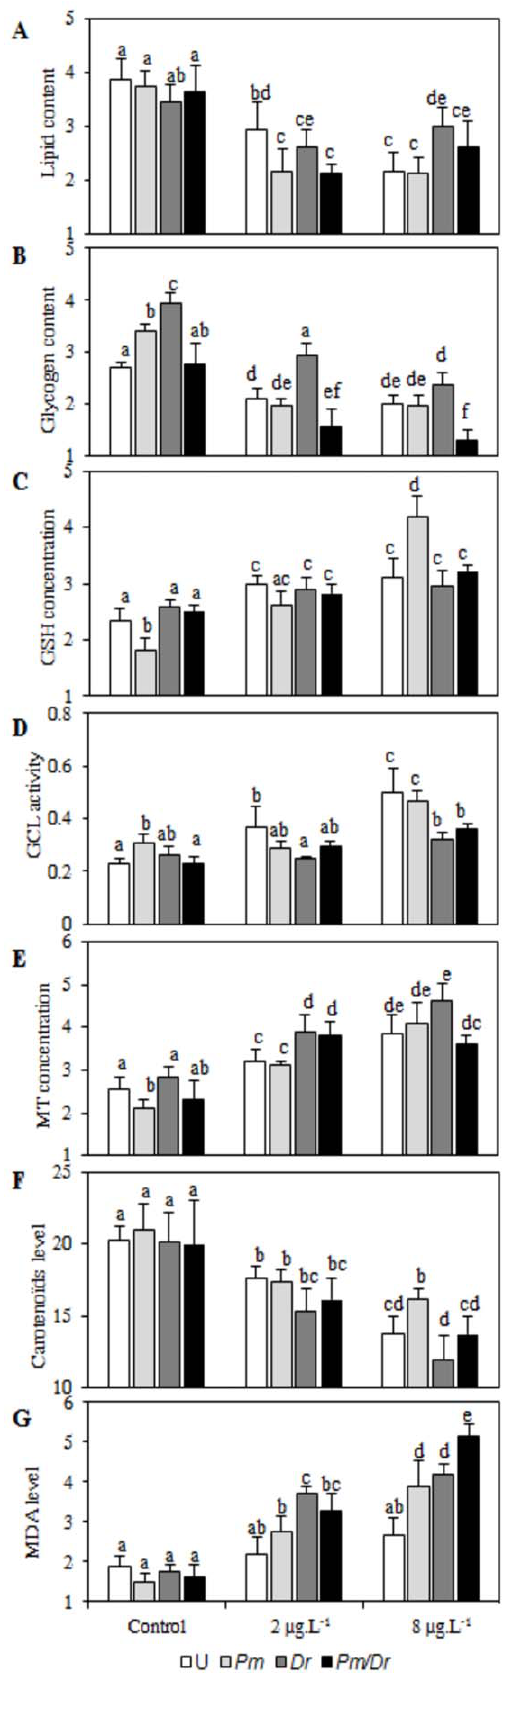
Figure 1. Influence of the presence of P. minutus and/or D. roeselum on energy and defences biomarkers of Gammarus roeseli females exposed to 2 and 8 m g Cd/L for 96 hrs. Pm: P. minutus -infected females, Dr: D. roeselum -infected females, Pm/Dr: bi- infected females. Different letters above the bars indicate significantly different values (Tukey’s HSD test, p -values , 0.05).